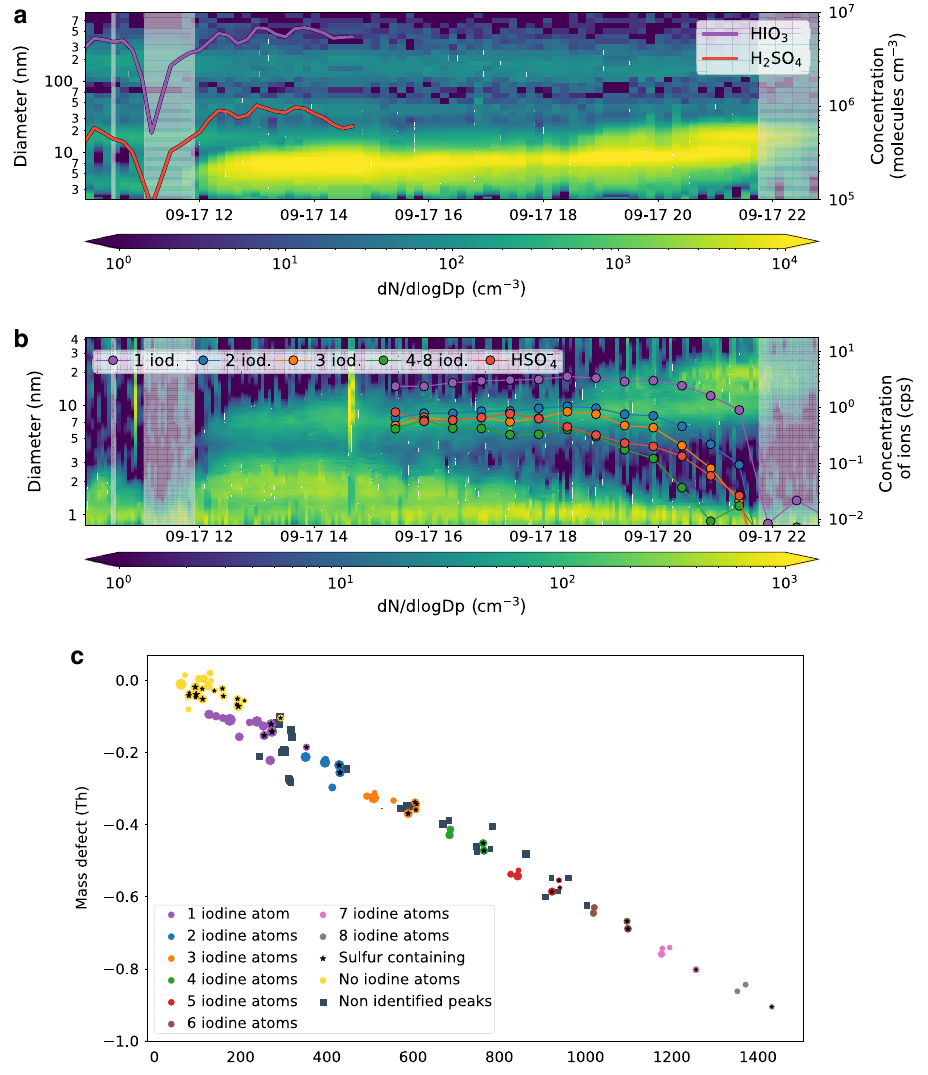
Fig. 1 New particle formation mechanisms over the pack ice shown for 17 September 2018. a Evolution of particle size distribution; also shown are the iodic and sulfuric acid monomer concentration measured with a nitrate chemical ionization mass spectrometer. b Negative-ion size distribution from neutral cluster and air ion spectrometer measurements and naturally charged sulfuric acid and iodine clusters measured with the negative atmospheric pressure interface time of fl ight (APi-TOF) mass spectrometer. The legend indicates the number of iodine atoms per cluster where clusters with the same number of iodine atoms were summed up. The concentration is given in counts per second (cps). Grey shaded areas indicate periods with fog (here associated to a visibility below 2 km). c Mass defect plot of the negatively charged ions measured with the APi-TOF. The size of the markers is proportional to the logarithm of the concentration. The iodine clusters reported in the mass defect plot are the same as shown in the bottom panel of Fig. 1b. Squares indicate peaks for which it has not been possible to unambiguously identify their chemical composition, however their mass defect is compatible with iodine containing